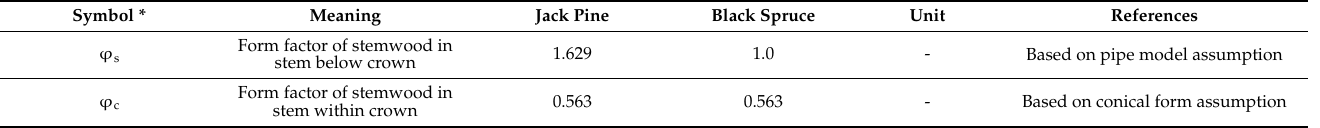
Table 2. Summary of jack pine and black spruce parameters and their